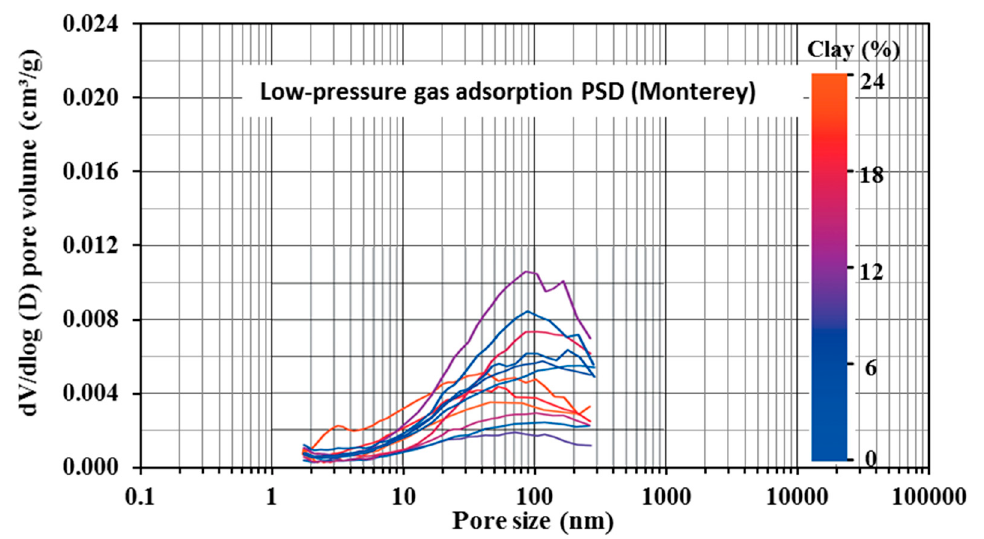
Figure 7. Monterey pore size distribution (PSD) derived from low-pressure N 2 gas adsorption. Modified from Saidian, Kuila [44].